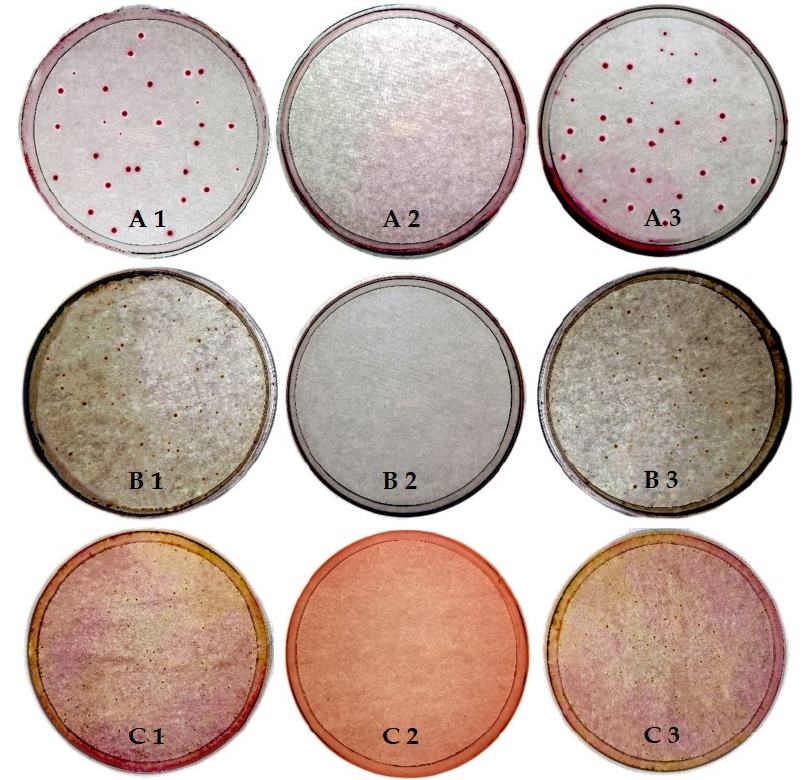
Figure 2. Agar plates of E. coli ( A ), P. aeruginosa ( B ) and S. aureus ( C ) growth after studied wash cycles in the presence of 3% HP as disinfectant agent: ( 1 ) prewash, ( 2 ) main wash and ( 3 ) rinse